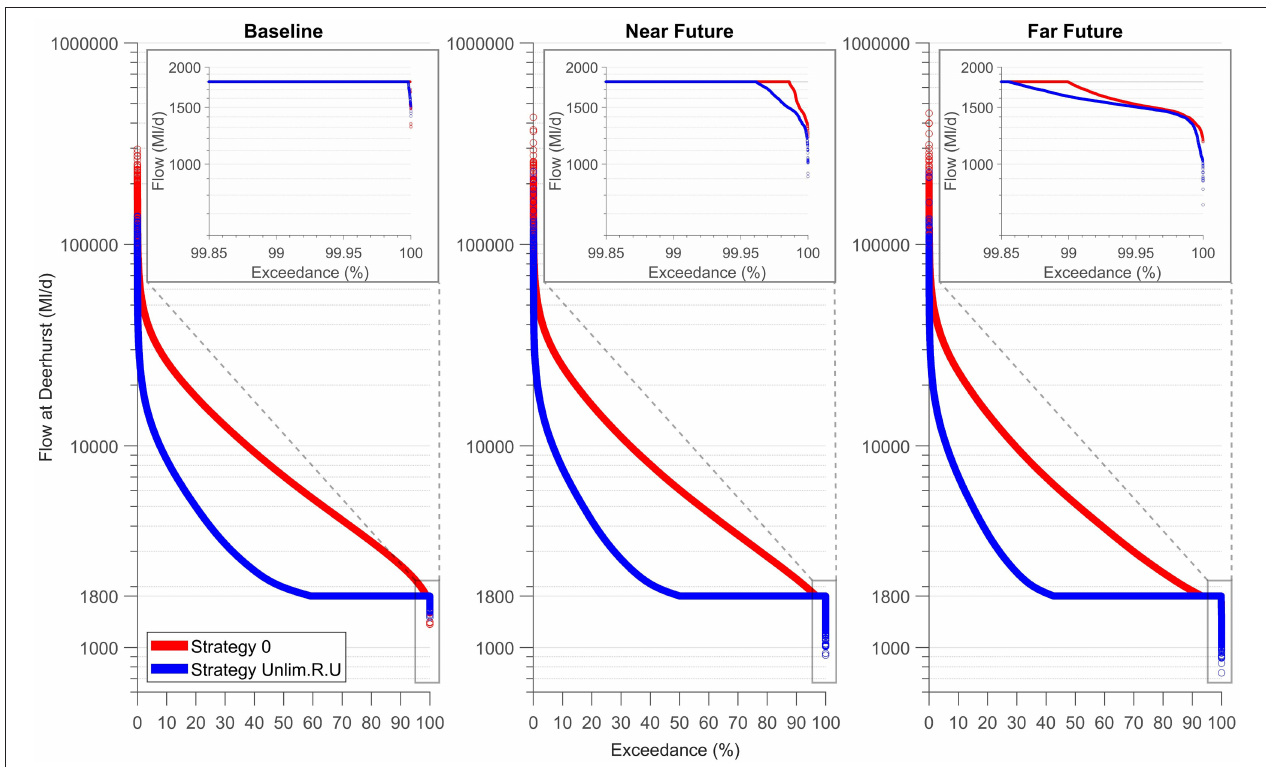
FIGURE 8 | Exceedance curves of flow at Deerhurst below transfer abstraction point for Strategy 0 and Strategy Unlim.R.U when simulated against W@H flow ensembles and demand projections in WATHNET-5. Minimum required flow (1800 Ml/d) at Deerhurst is marked on the maximized plots of the lower end of the exceedance